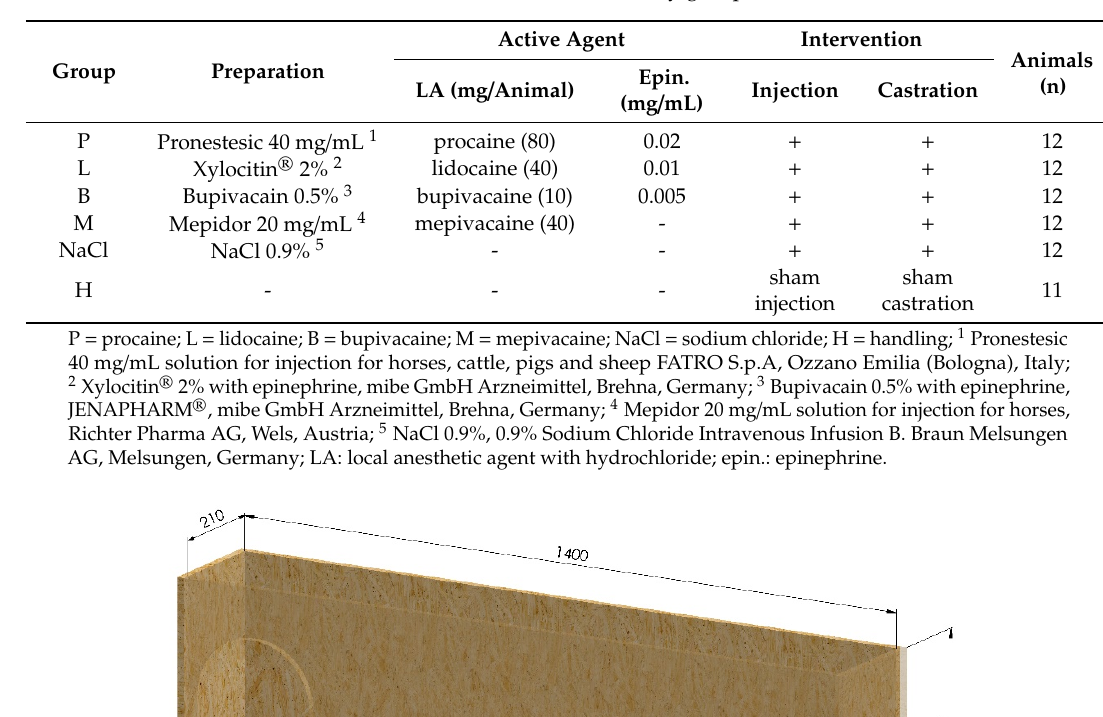
Table 1. Classification of study groups.